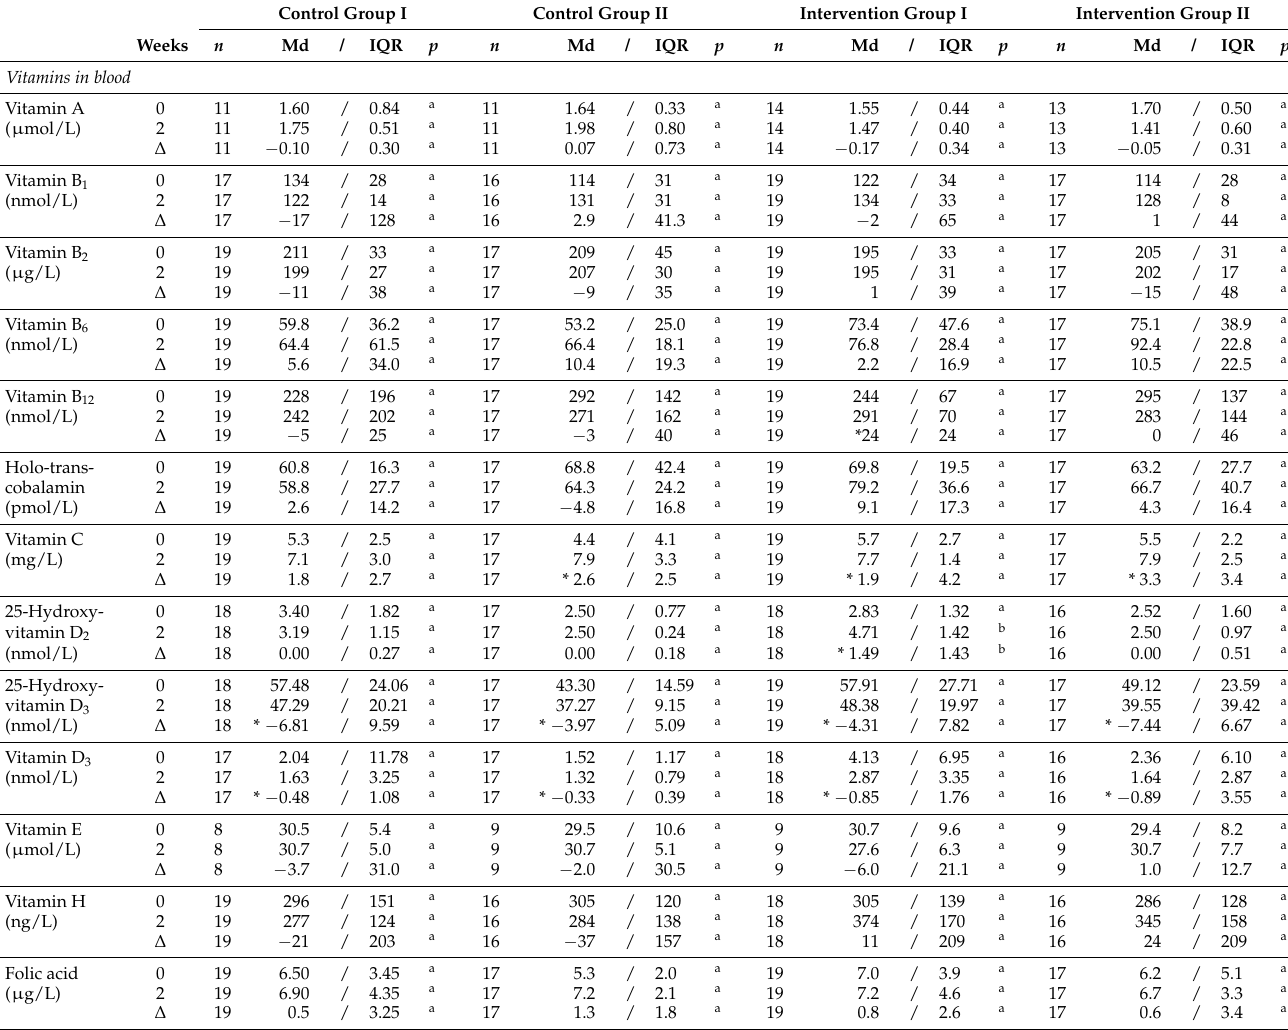
Table 3. Nutrient status of the NovAL study participants based on blood and urine parameters ( n =